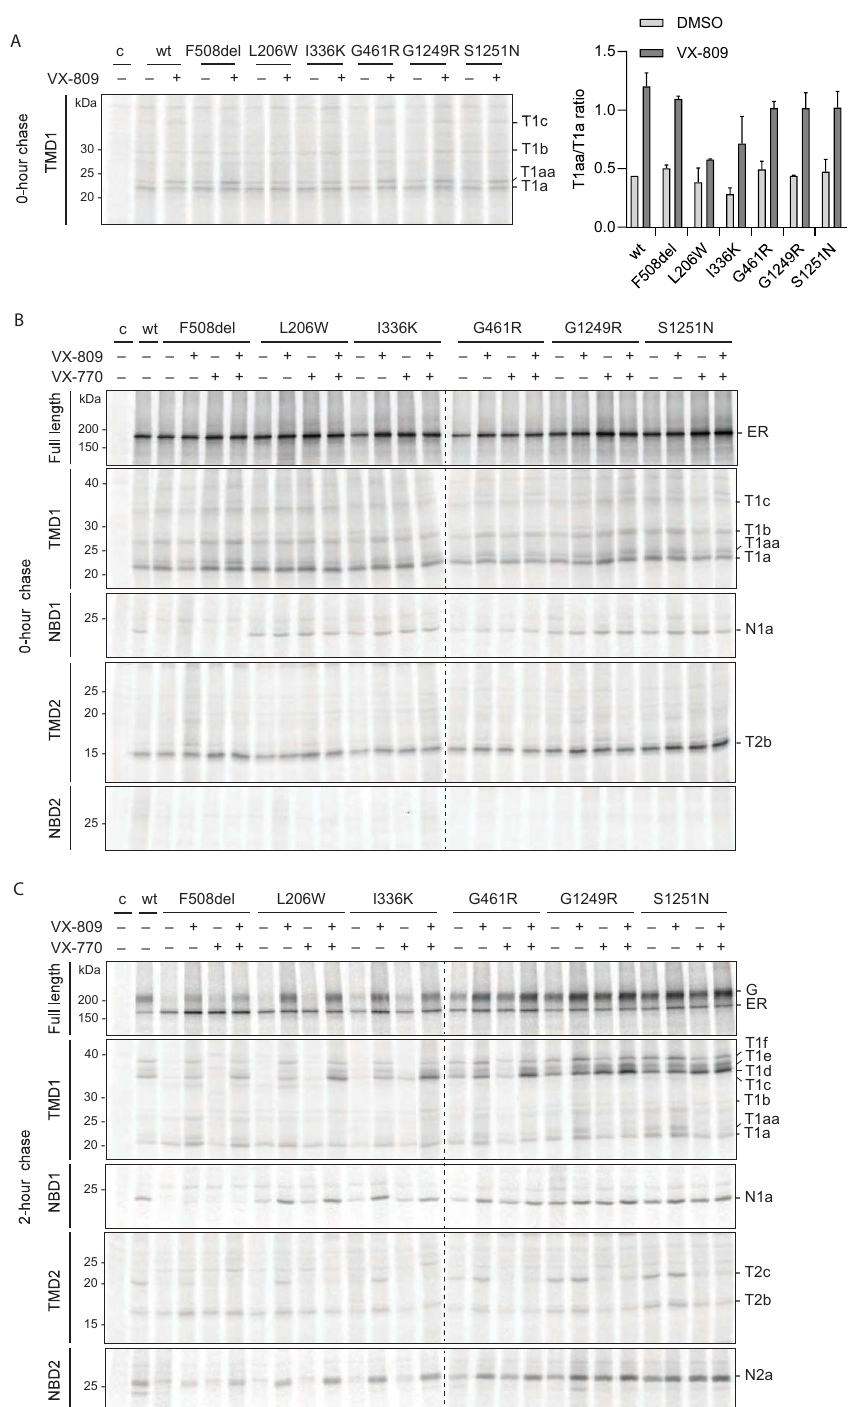
Figure 6. Hyper-responders show conformational responses to modulators ( A ) HEK293T cells expressing wild-type and mutant CFTR were radiolabeled for 15 min. Where indicated, VX-809 (3 µ M) was added during the starvation, pulse, and chase. TMD1 proteolysis was analyzed as in Figure 4A. Quantifications based on three independent experiments. ( B ) CFTR was analyzed as in Figure 4B. VX-809 (3 µ M) or VX-770 (3 µ M) were added during starvation, pulse, and chase. The top panel shows undigested CFTR and the lower panels show domain-specific fragments immunoprecipitated after digestion with 25 µ g/mL proteinase K. ( C ) As in ( B ), but radiolabeled CFTR was chased for 2 h. Representative gels for each construct are shown. Data are used for plots